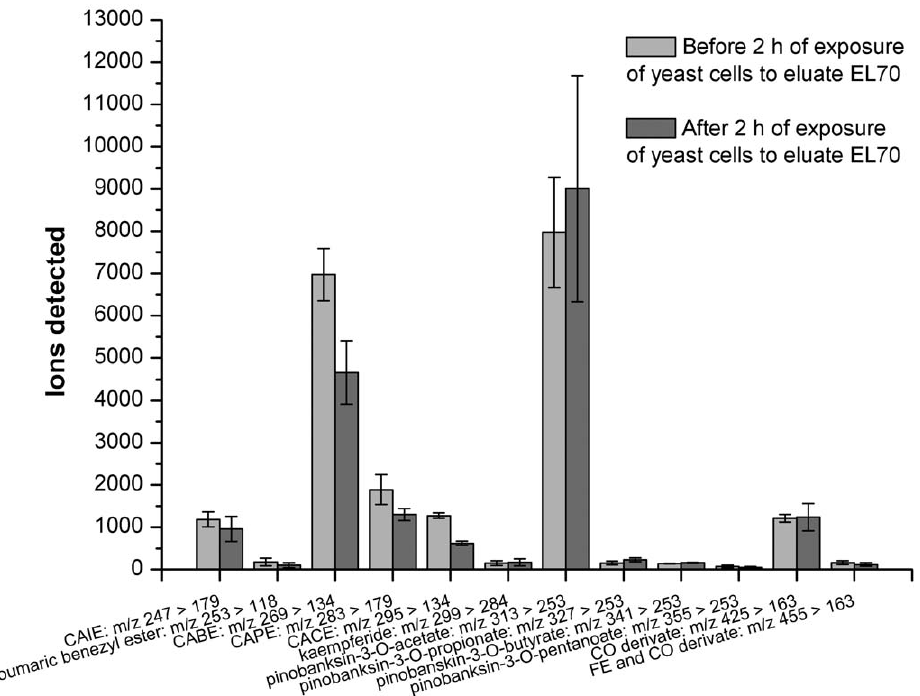
Figure 8. LC-MS/MS of the phenolic compounds in the incubation medium before and after 2 h of exposure of the yeast S.cerevisiae to eluate EL70 (1%). Data are means 6 S.D. (n=3), and are expressed as the detected ions. CAIE, caffeic acid isoprenyl ester; CABE, caffeic acid benezyl ester; CAPE, caffeic acid phenethyl ester; CACE, caffeic acid cinnamyl ester; CO, coumaric acid; FE, ferulic acid.